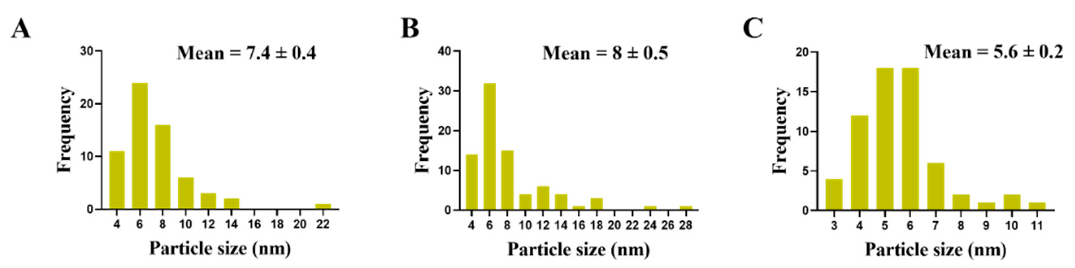
Figure 5. Particle size of Ag-NPs in Candida albicans cells treated with AgNO 3 ( A ), D-SNPs ( B ) or N-SNPs ( C ).